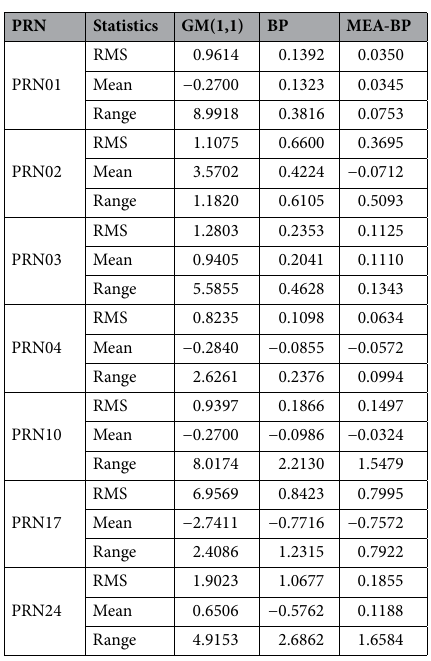
Table 6. Statistics of 3 h prediction results of the seven satellites (unit: ns).